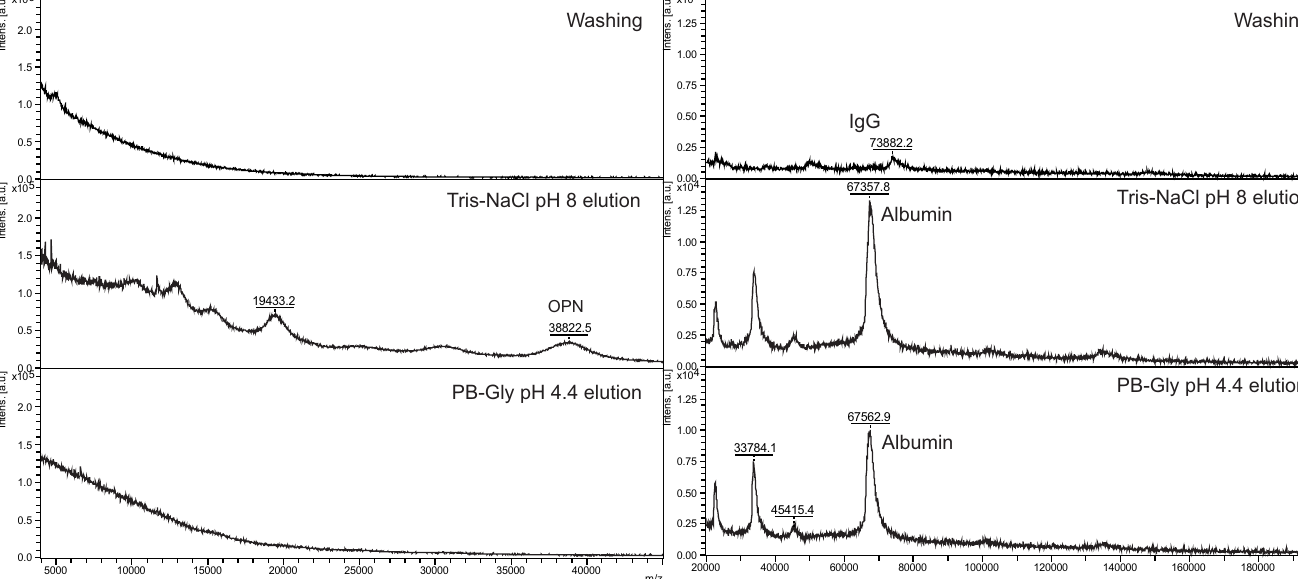
PLOS ONE | https://doi.org/10.1371/journal.pone.0213405 March 7,